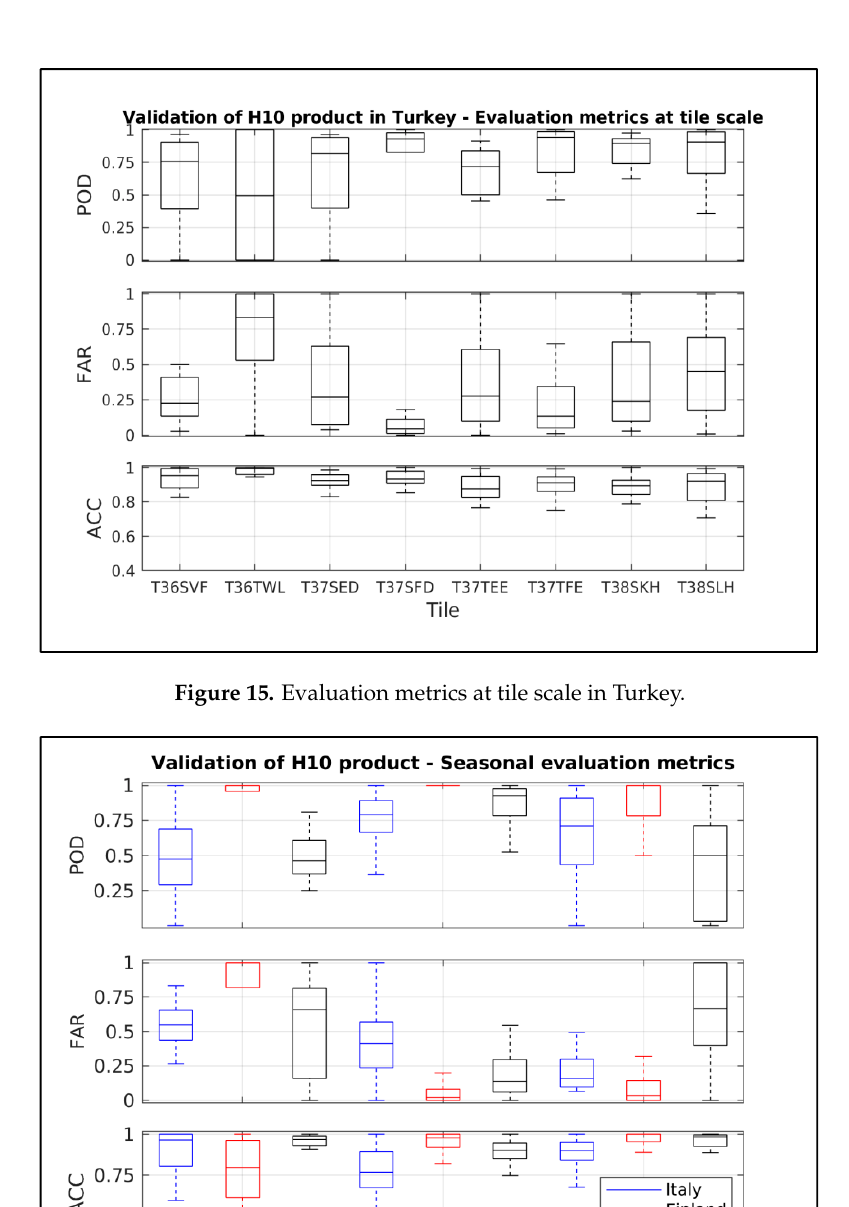
Figure 16. Seasonal evaluation metrics in Italy, Finland, and Turkey.